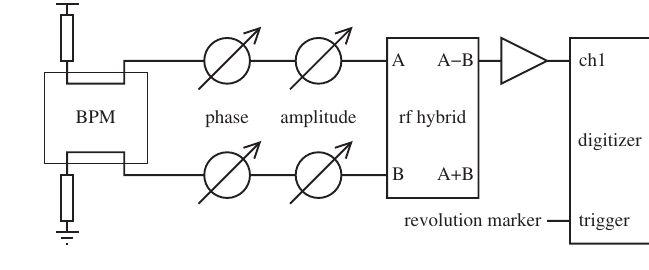
FIG. 2. Schematic diagram of the apparatus.